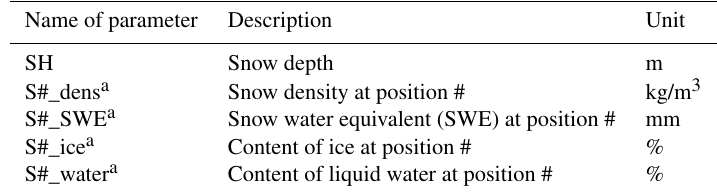
Name of parameter